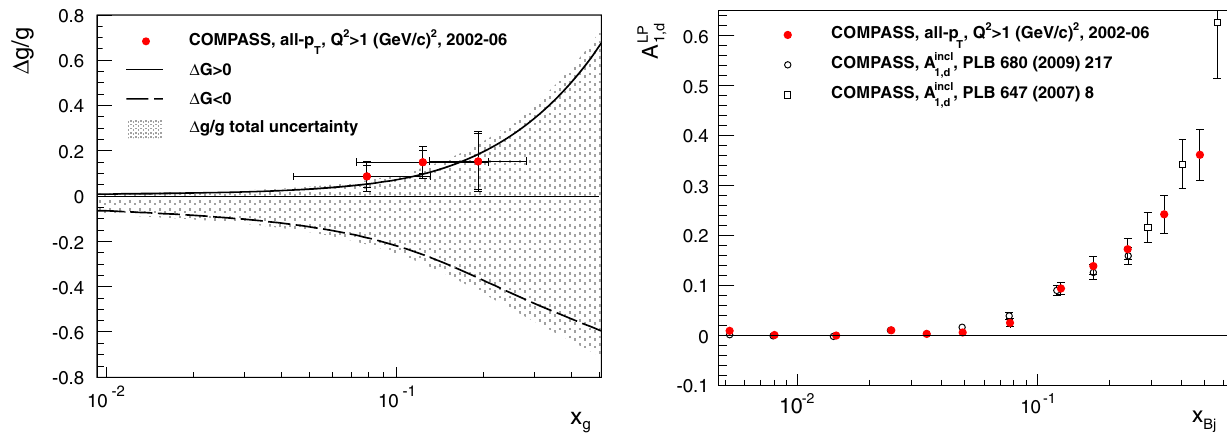
Fig. 6 Left panel Comparison of the LO results of the present analysis with the latest NLO QCD fit results from COMPASS [37]. Otherwise as in Fig. 5. Right panel Extracted values of A LP